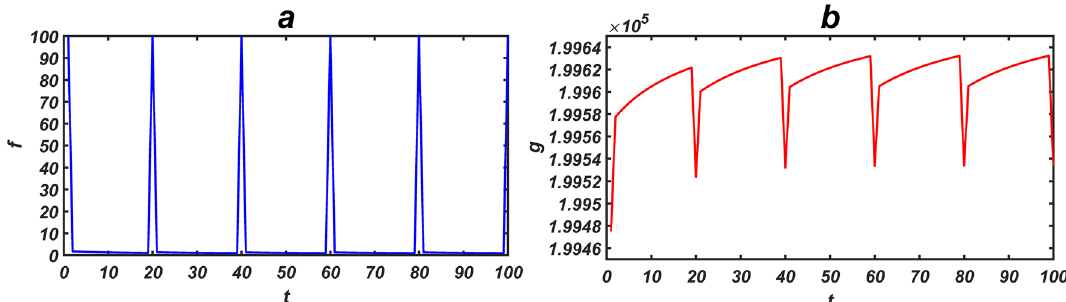
Figure 2. The graph shows f and g in a network with 100 nodes and average degree 〈 k = 10 〉 . The initial value of the state of nodes is considered to be 1. ( a ) The horizontal axis represents the intervals from t = 1 to t = 100 , where the input signal is applied to the network at t = 1, 20, 40, 60, 80, 100 . ( b ) The function g where an input signal with a value of -100 is to all nodes in 20 consecutive steps.